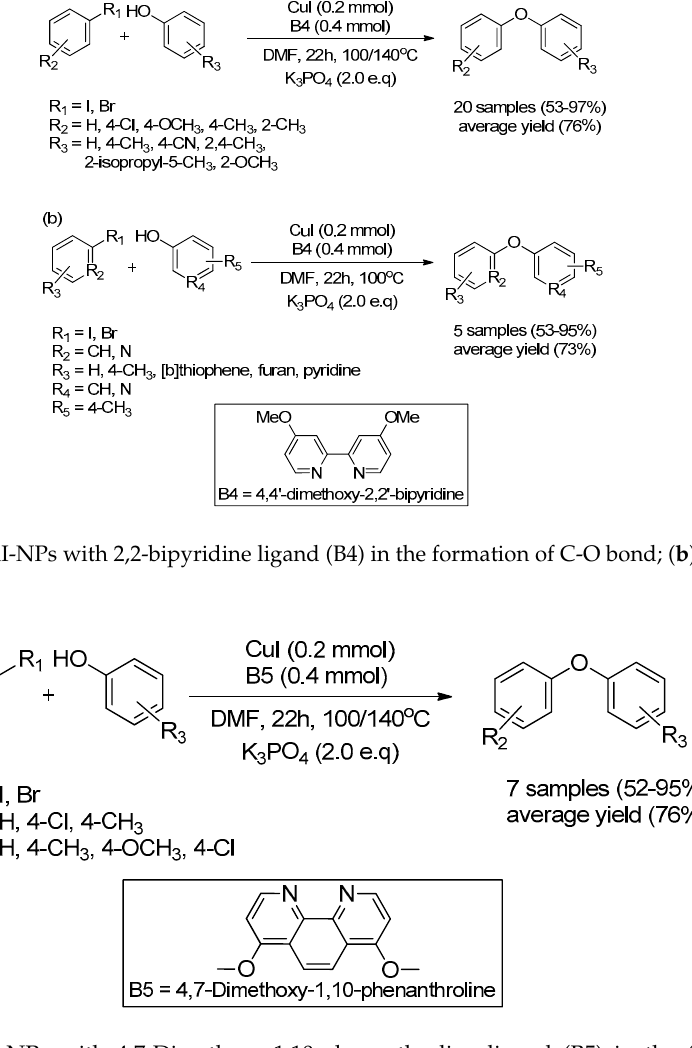
Figure 13. Imidazolium-based NHC ligands precursor.